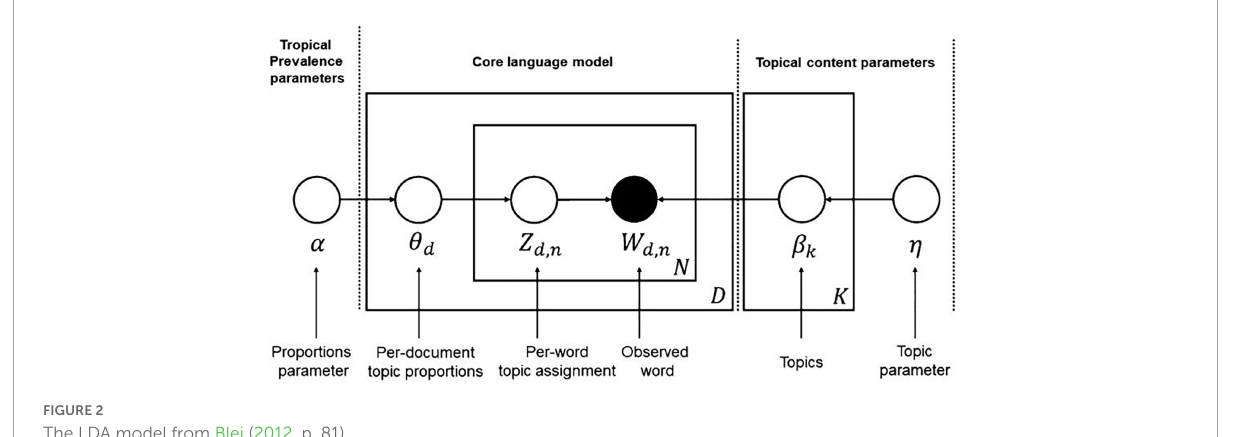
FIGURE2 The LDA model from Blei (2012, p.